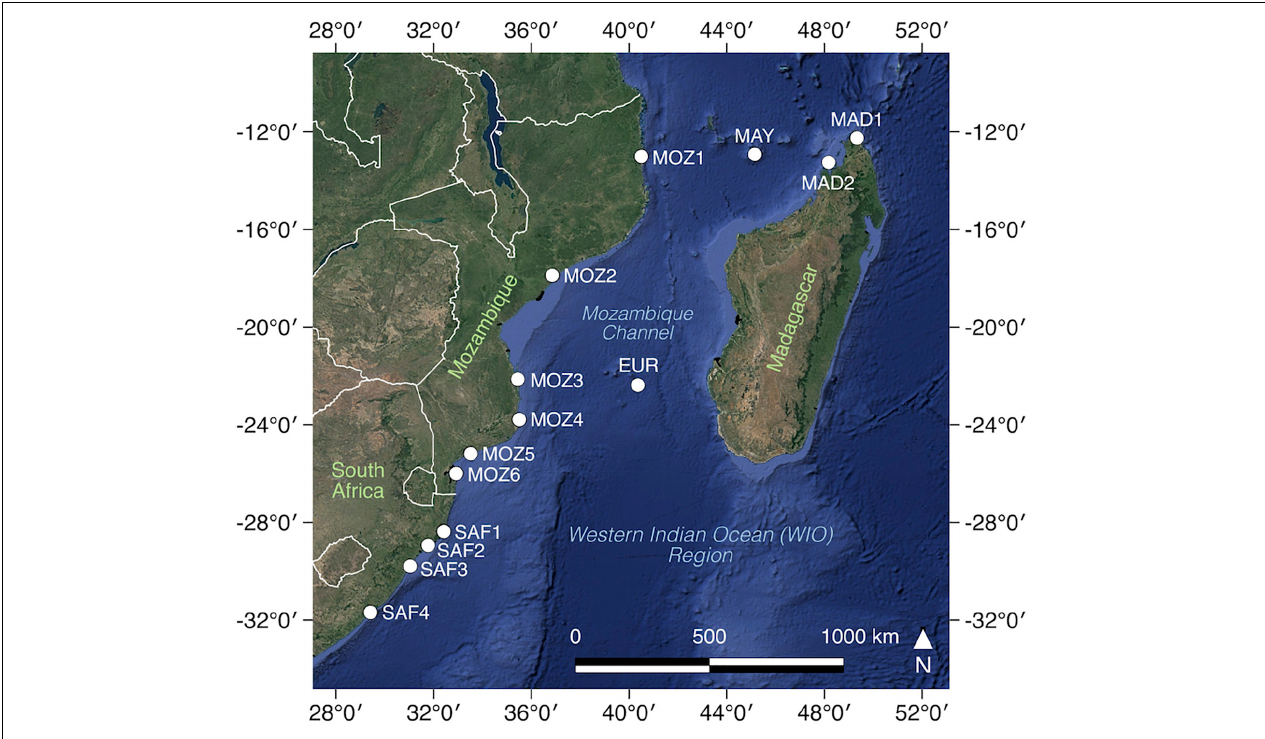
FIGURE 1 | Sampled Avicennia marina populations in the Western Indian Ocean Region. Population codes are denoted in Table 1 . Coastal landform maps with transect details of each population are in Supplementary Figure 1 . Map generated using the Quantum Geographical Information System, version 2.18.13 (www.qgis.org). Basemap source: Google Satellite. Country boundaries are from Natural